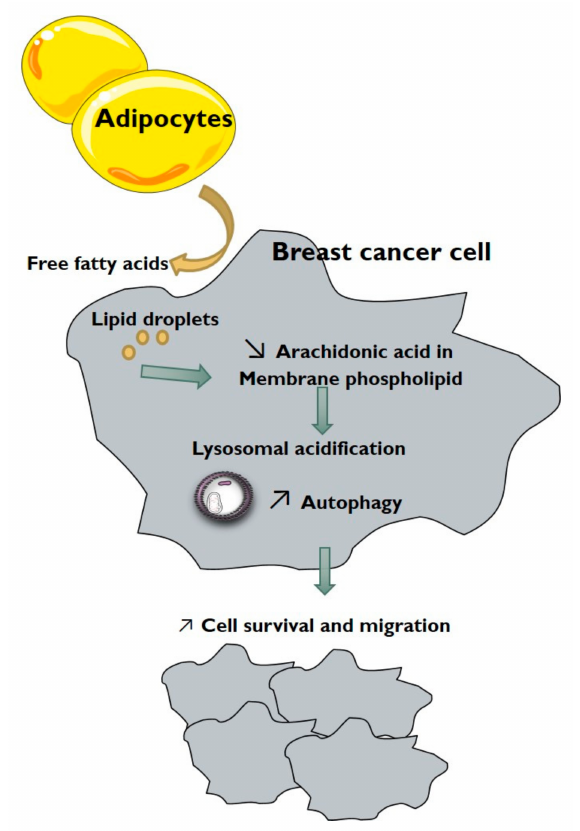
Figure 8. Schematic diagram depicting the interaction between adipocytes and breast cancer cells. The model describes the role of fatty acids in the modulation of autophagy in breast cancer cells and consequently in cancer cell survival and